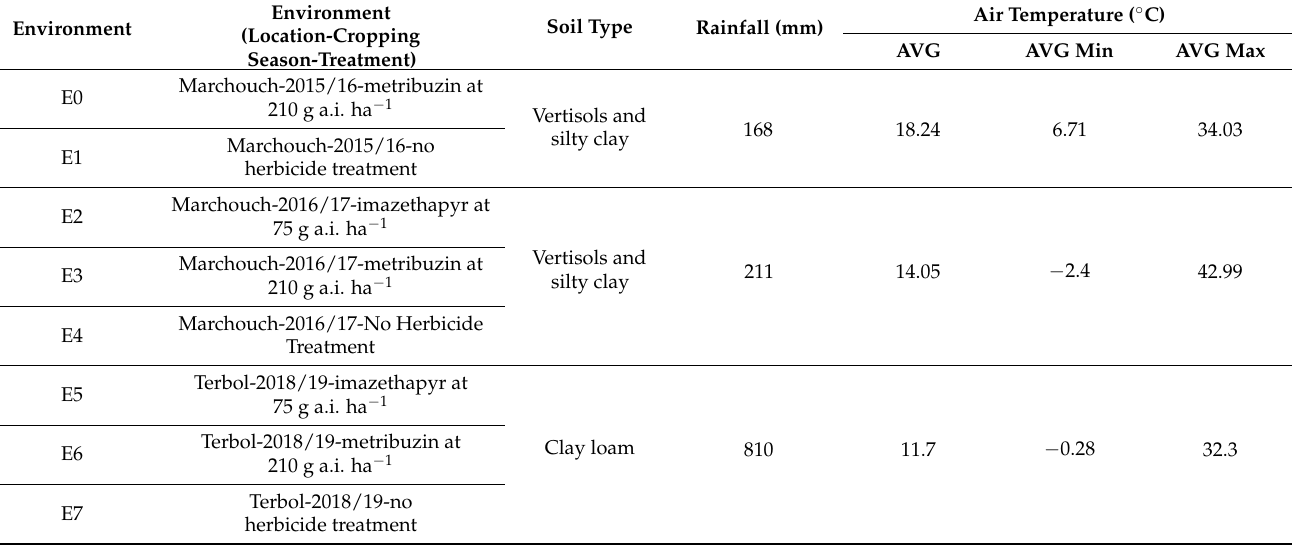
Table 7. Specifications and details of the various environments tested for lentil screening.